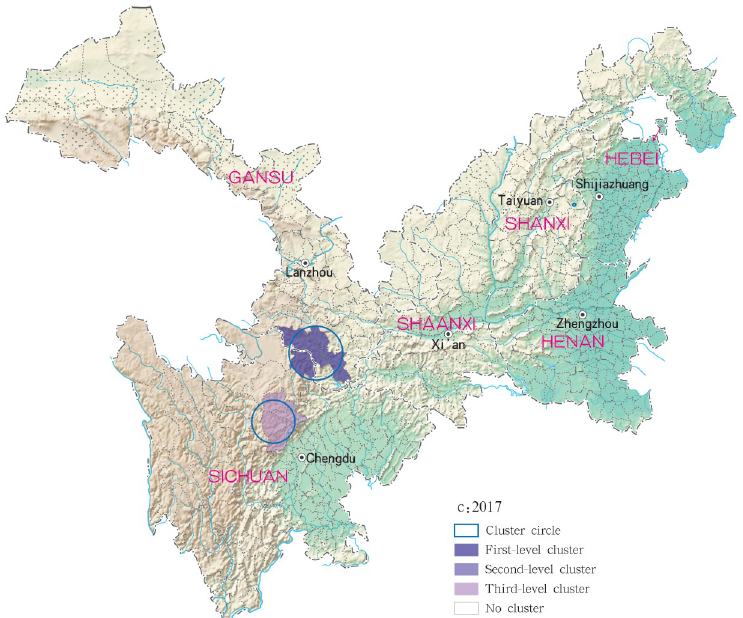
Fig 13. Spatio-temporal clustering analysis of mountain-type zoonotic visceral leishmaniasis incidence in 6 provinces, China in 2017.